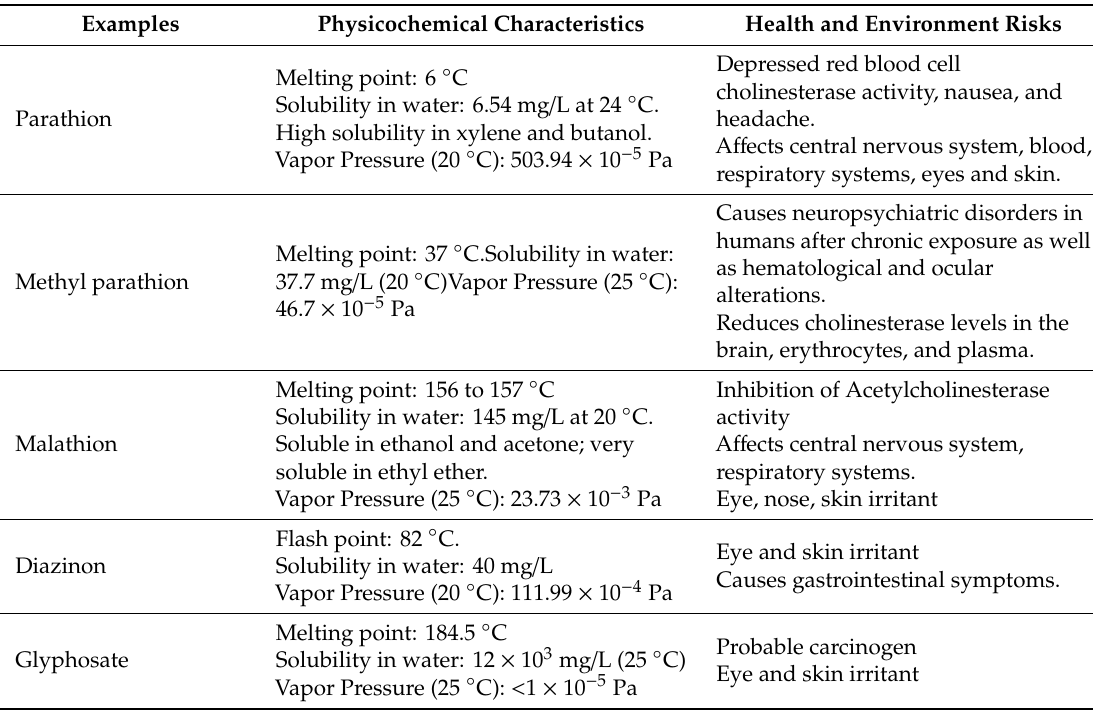
Table 2. Some examples of organophosphates pesticides, which are esters of phosphoric acid, containing a phosphate group as their basic structural framework